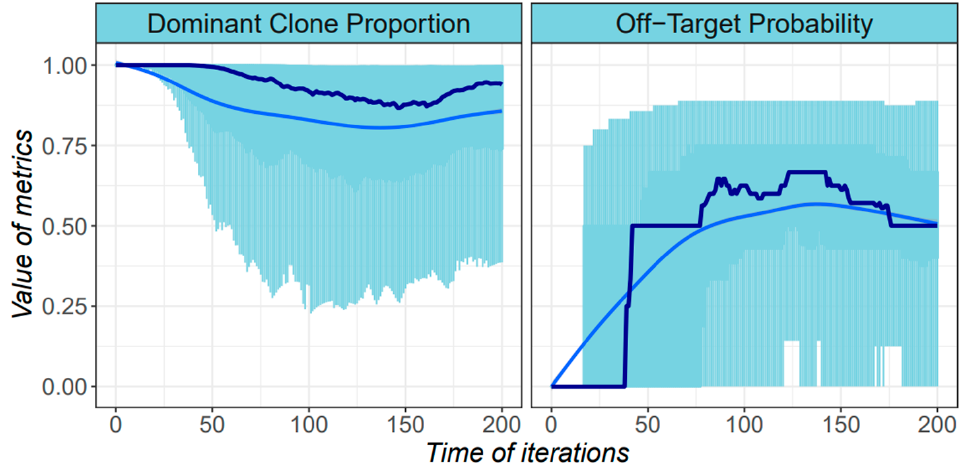
Figure 6. The distribution of the ITH metrics among simulations. Boxplots are used to represent the distributions of corresponding values from all of the simulations. The x axis denotes the time, and the y axis denotes the value. 200 simulations are performed and two metrics are calculated at each time point. The dark blue line indicates the median value from all simulations, and the blue curve indicates a loess regression based on the values.